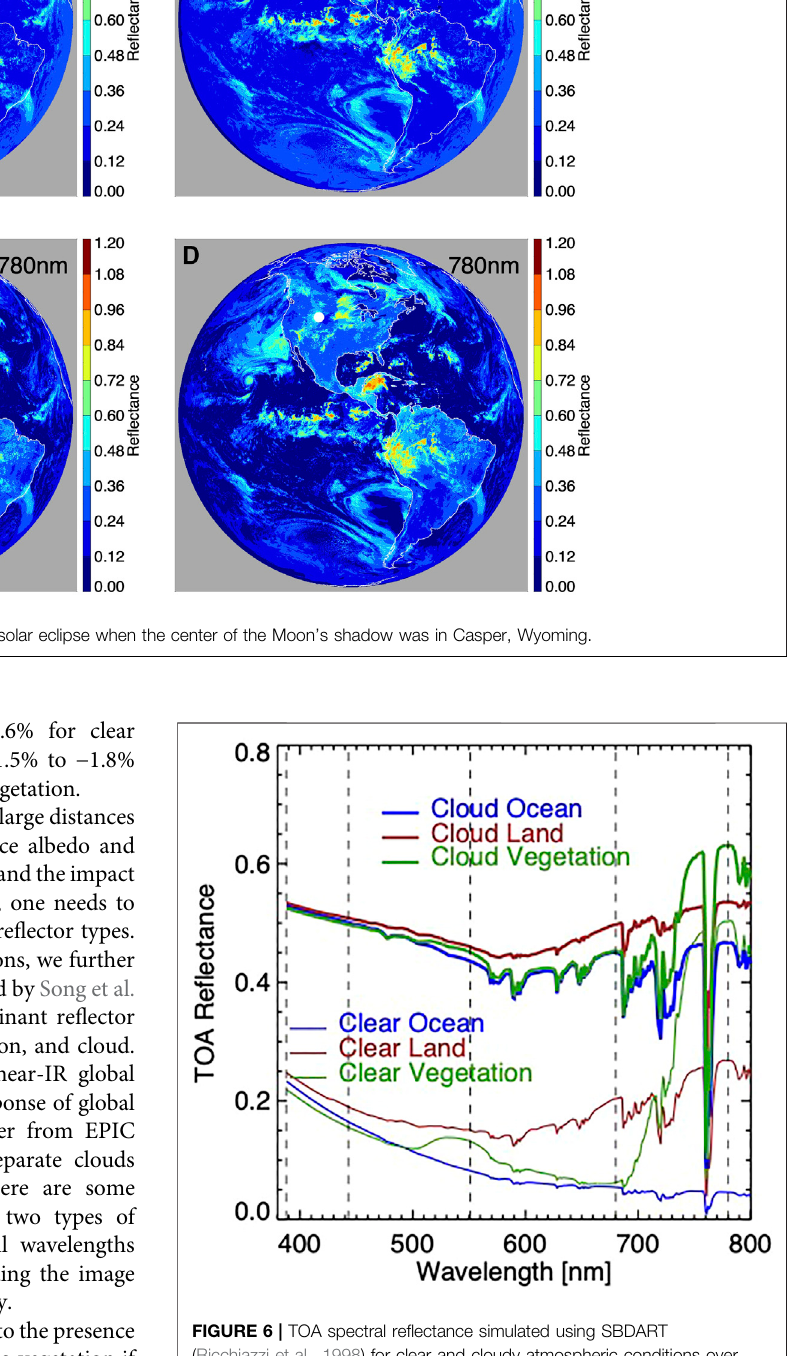
Frontiers in Remote Sensing |